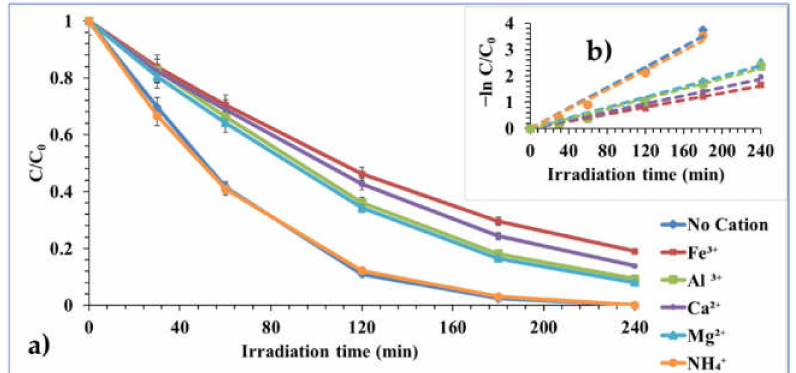
Figure 14. ( a ) Cation effect on the photocatalytic degradation performance of 1 g/L Mo/SynTiO 2 over 5 mg/L initial CBZ concentration under natural (unmodified) pH 5.84 and 365 nm irradiation, and ( b ) their corresponding photocatalytic degradation rate constant (k).